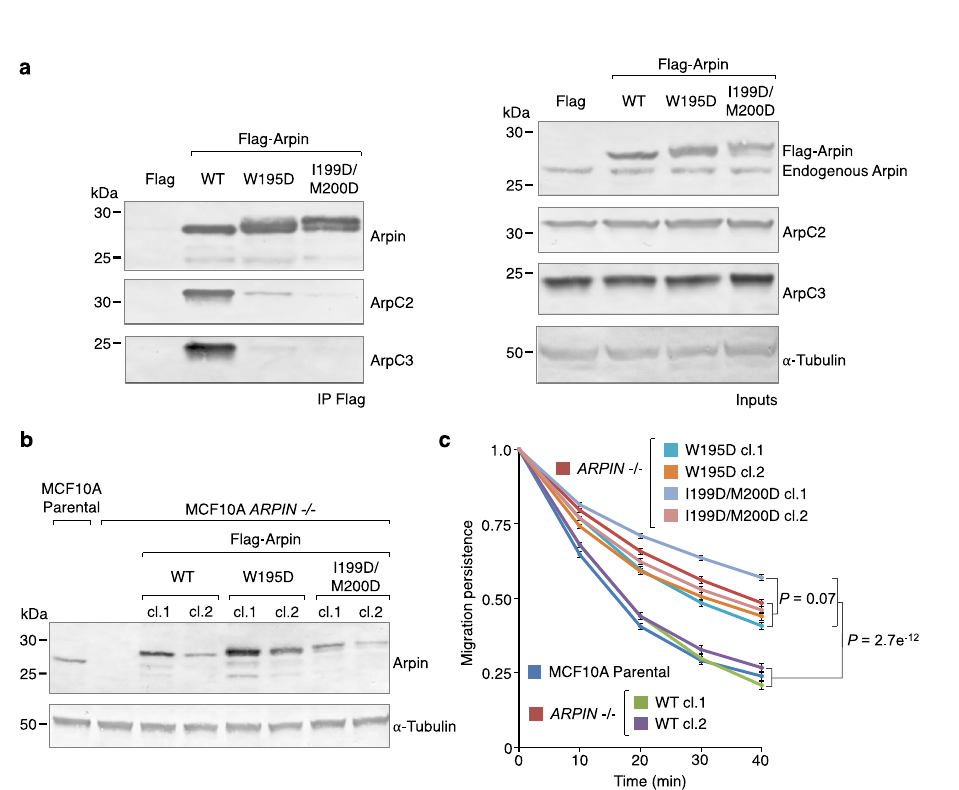
Fig. 5 Arpin C-helix mutants impair Arp2/3 complex binding and cell migration. a Immunoprecipitation of Arp2/3 complex subunits ArpC2 and ArpC3 from HEK-293T cells expressing Flag-tagged Arpin WT and mutants W195D and I199D/M200D. Right panel shows the loading controls of cell extracts and reveals both endogenous and exogenously expressed Arpin. b Western blot detection of Flag-tagged Arpin WT and mutants W195D and I199D/ M200D expressed in ARPIN − / − stable MCF10A cell lines (loading control, α -tubulin). Arpin is not detected in control ARPIN − / − cells extracts. Uncropped and unprocessed blots are provided as a Source Data fi le. c Migration persistence of control parental and ARPIN − / − MCF10A cells compared to those of ARPIN − / − cells expressing constructs Arpin WT and mutants W195D and I199D/M200D (raw migration data in Supplementary Fig. 5c). The statistical signi fi cance of the measurements was calculated using a one-way ANOVA test (exact P -values are listed in the fi gure). Source Data are provided as a Source Data fi le. N = 74 cells for MCF10A parental, ARPIN − / − and WT cl.1, N = 72 cells for WT cl.2, N = 75 cells for W195D cl.1, N = 69 cells for W195D cl.2, N = 76 cells for I199D/M200D cl.1, and N = 67 cells for I199D/M200D cl.2. Results are expressed as means and standard error of the